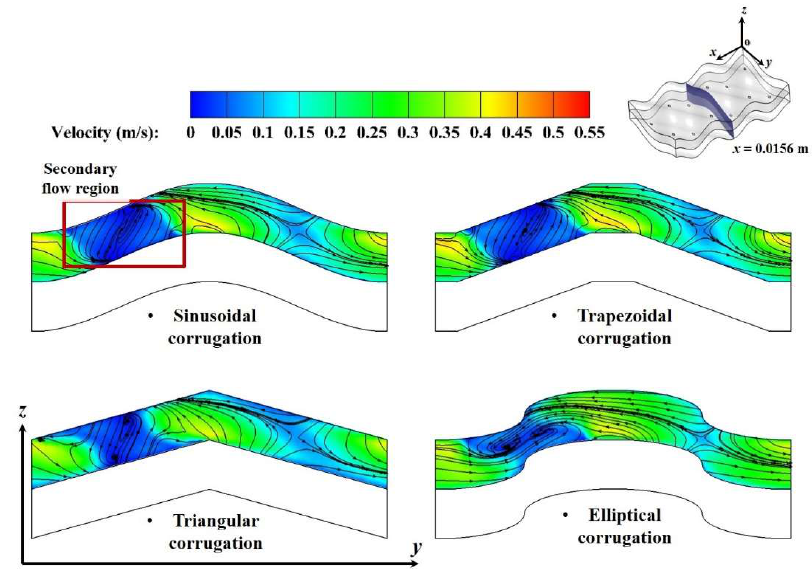
Figure 7. Velocity magnitude distributions for various corrugation profiles at x = 0.0156 m.